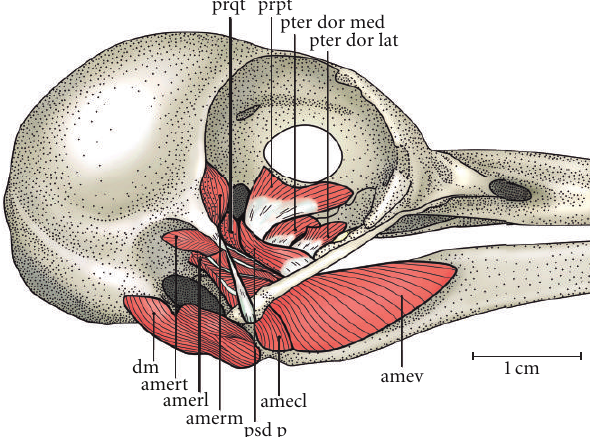
Figure 1: A lateral superficial view of the jaw muscles of Blythipicus rubiginosus. amecl: adductor mandibulae externus caudalis lateralis; amerl: adductor mandibulae externus rostralis lateralis; amerm: adductor mandibulae externus rostralis medialis; amert: adductor mandibulae externus rostralis temporalis; amev: adductor mandibulae externus ventralis; dm: depressor mandibulae; prpt: protractor pterygoidei; prqt: protractor quadrati; psd p: pseudotemporalis profundus; pter dor lat: pterygoideus dorsalis lateralis; pter dor med: pterygoideus dorsalis medialis.